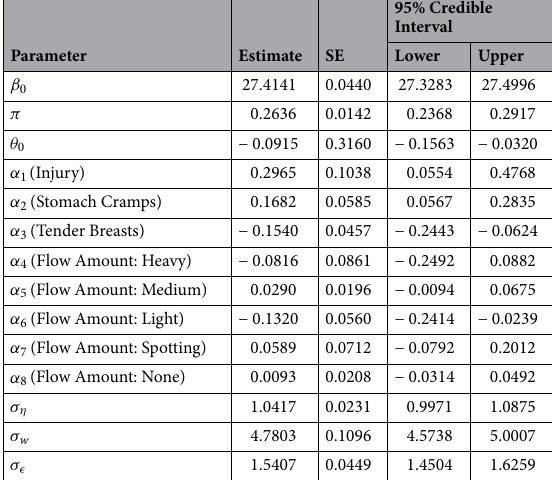
Table 3. Posterior means and 95% Bayesian credibility interval for (cid:31) .